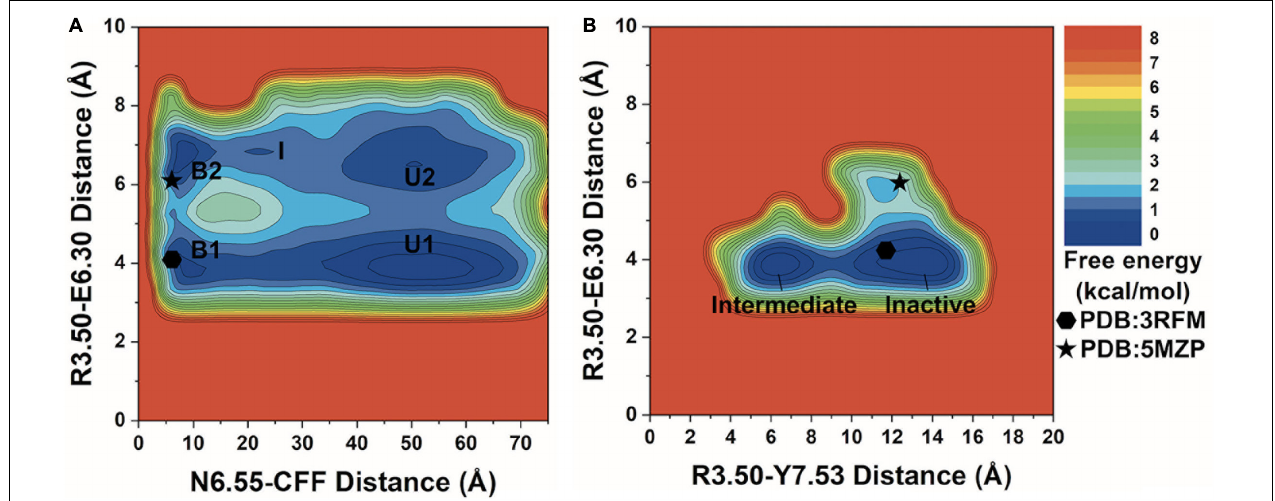
FIGURE 2 | 2D potential of mean force (PMF) free energy profiles of the A 2A AR–caffeine (CFF) interactions. (A) Two-dimensional (2D) PMF of the distance between receptor residue N6.55 atom ND2 and CFF atom N1 and the ionic lock distance between charge centers of receptor residues R3.50 and E6.30. The low-energy states are labeled in the PMF profile, including the unbound (U1 and U2), intermediate (I), and bound (B1 and B2). (B) 2D PMF of the distance between atom CZ in receptor residue R3.50 and the hydroxyl oxygen atom of residue Y7.53 and the ionic lock distance between charge centers of receptor residues R3.50 and E6.30. The low-energy inactive and intermediate conformational states are labeled. The 3RFM and 5MZP PDB structures of inactive A 2A AR are mapped to the free energy surface as hexagons and